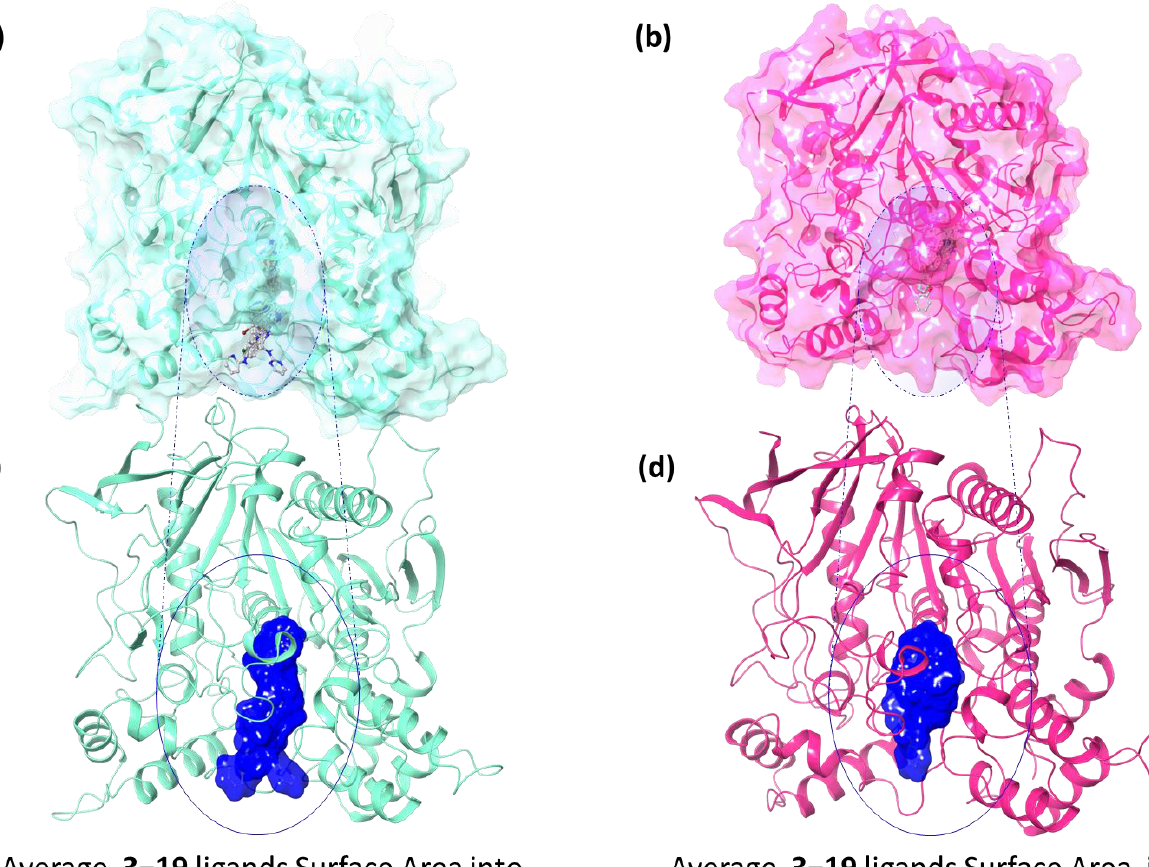
Figure 3. Superposition of all synthesized ligands into ( a ) h AChE and ( b ) h BChE binding pocket, surrounded by a blue circle. The ligands are illustrated as grey carbon ball and sticks representations. Panels ( c , d ) are focused on the solid ligand surface ( blue ) occupied by all compounds in h AChE and h BChE, respectively. The average 3 – 19 ligands’ surface area in both the h AChE and h BChE pocket are reported below each 3D representation.